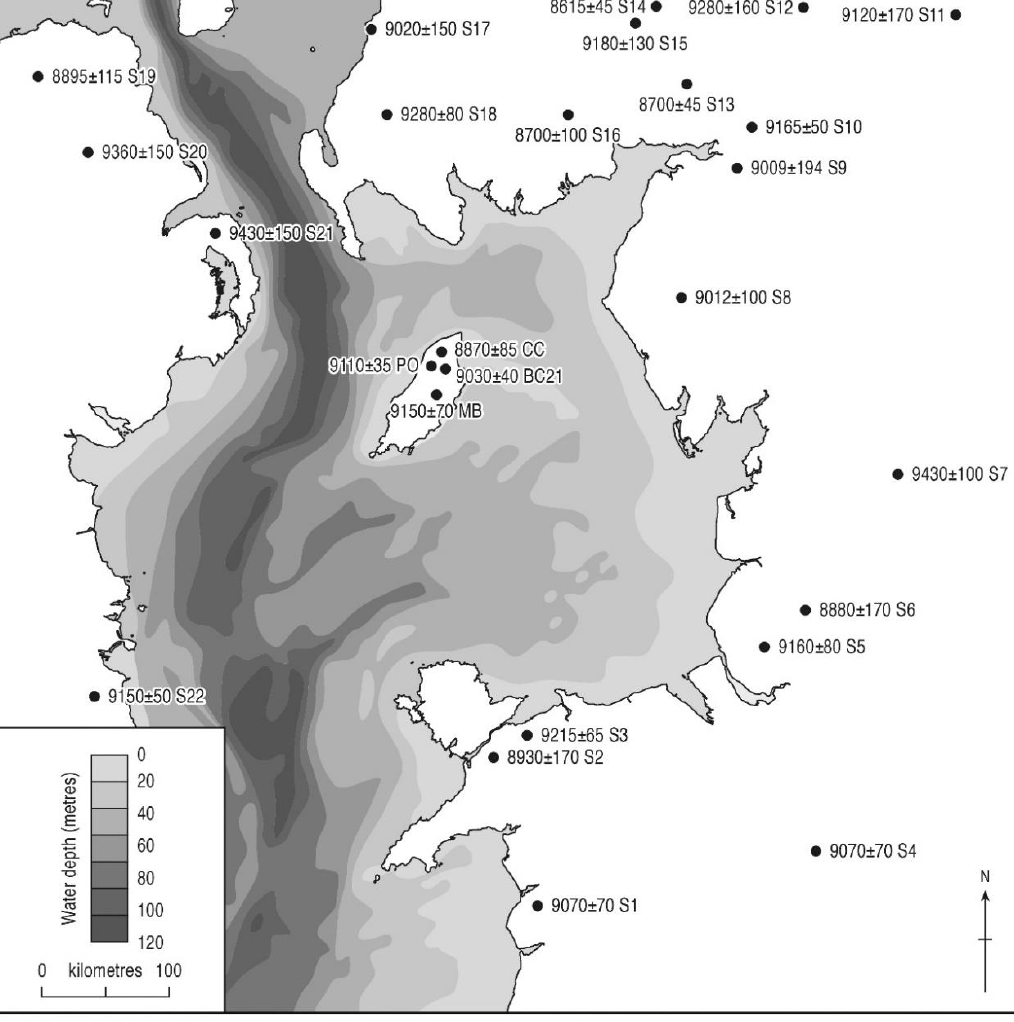
Figure 12. Radiocarbon ages for the Corylus rise in the northern Irish Sea region. For sources and date calibration ranges see Supplementary File S1.